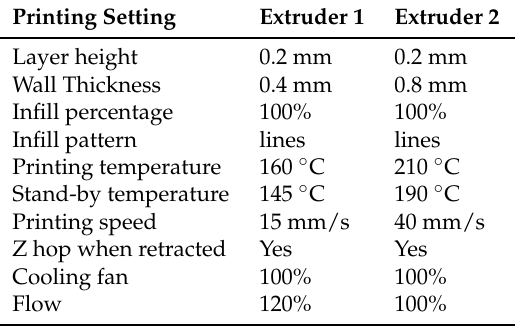
Table 2. 3D-printer settings for conductive filament